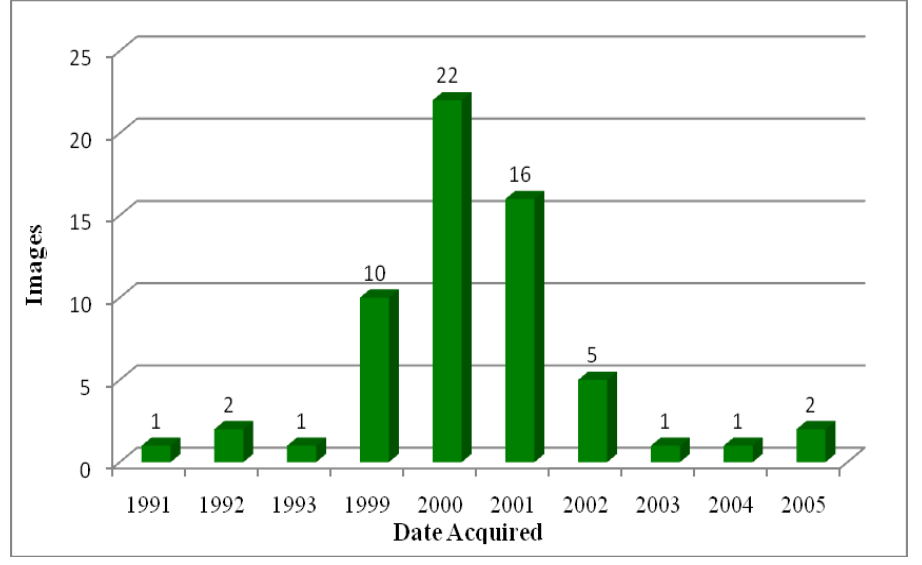
Figure 3. Majority of imagery used for analysis were acquired circa